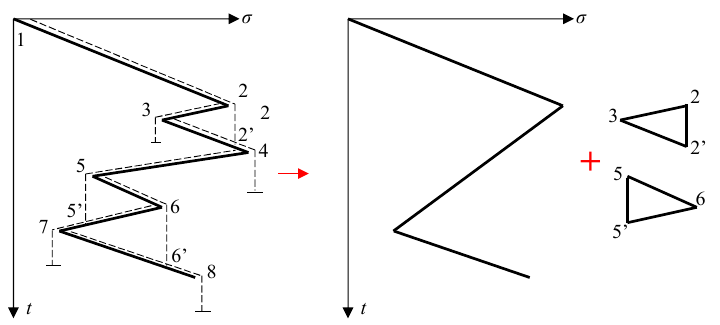
Figure 3. Rain-flow counting method.